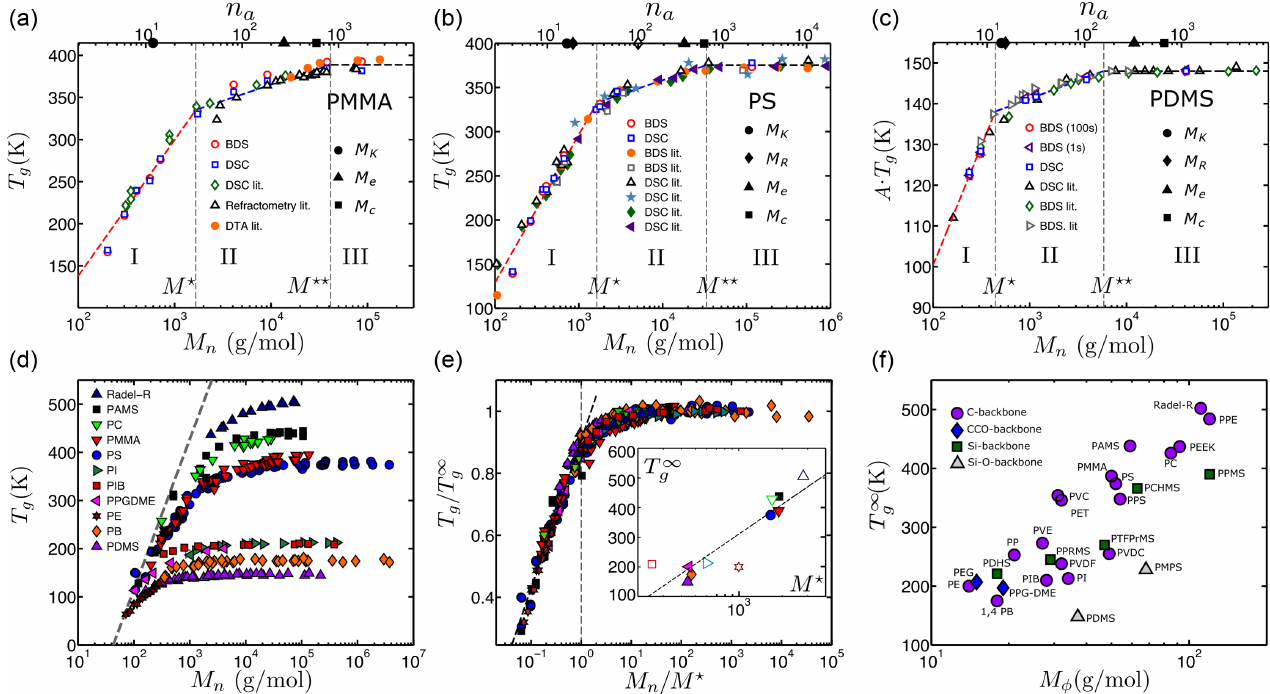
FIG. 2. (a) – (c) T as a function of the number-averaged molecular weight M and the number of backbone atoms n . We use M g n a n throughout except for Radel-R and one literature data set for PS (Appendix E), for which only theweight-averaged molecular weight M is w known. Data from BDS and DSC are combined with literature data for PMMA, PS, and PDMS (Appendix E). The experimental values of T M Þ vary slightly because of the nature of the experimental probe, T definition, or polymer specification. For PDMS, these differences g ð g ∼ 40 K); a scaling factor A ∼ 1 – 1 . 03 was thus introduced to collapse are more pronounced since T is only weakly varying with M ( Δ T g g M Þ forPDMS in Ref. [20] wasdefined for τ α ¼ 1 s, we plot different PDMSdata sets, where A ¼ 1 forthe T data from Ref. [47]. Since T g g ð M Þ . The symbols on the upper abscissa denote the Kuhn molecular weight (filled black absolute shift in T , thisyields the same shape of T g g ð (filled black diamond, or diamond for an alternative M definition [20]), the circle), the dynamical or Rouse molecular weight M R R entanglement molecular weight M (filled black up-pointing triangle), and the critical molecular weight M (filled square); all values are e c A B tabulated in Table IV. The red, blue, and black dashed lines are fits, respectively, to T log 10 M in regimes I and II, and g ¼ I ; II þ I ; II T T ∞ M Þ for 11 in regime III. The vertical dashed lines at M ⋆ and M ⋆⋆ denote the boundaries between the different regimes. (d) T g g ¼ g ð M Þ for rigid nonpolymeric glass formers, as discussed in the text. different polymers (Appendix E) [48]. The dashed line indicates T g ð ≡ T =T ∞ M → ∞ Þ . The insetshows T ∞ (e) T vs M=M ⋆ , where T ∞ vs log 10 M (cid:2) (open symbolsdenote polymerswith less certaintyin M (cid:2) g g ð g g g due to data that do not cover all three regimes). (f) T ∞ vs the mass M ϕ per conformational degree of freedom for polymers with different g backbone chemistries (Appendix E), as signified by different colors and shown in the